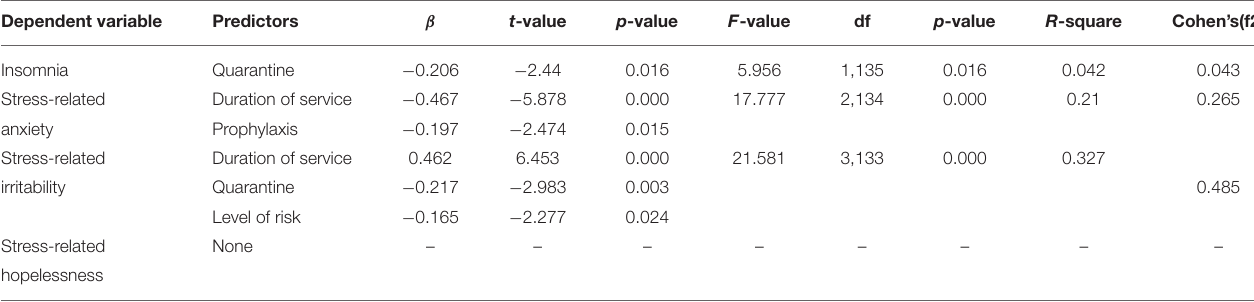
TABLE 6 | Results of stepwise linear regressions with clinical-professional variables. Dependent